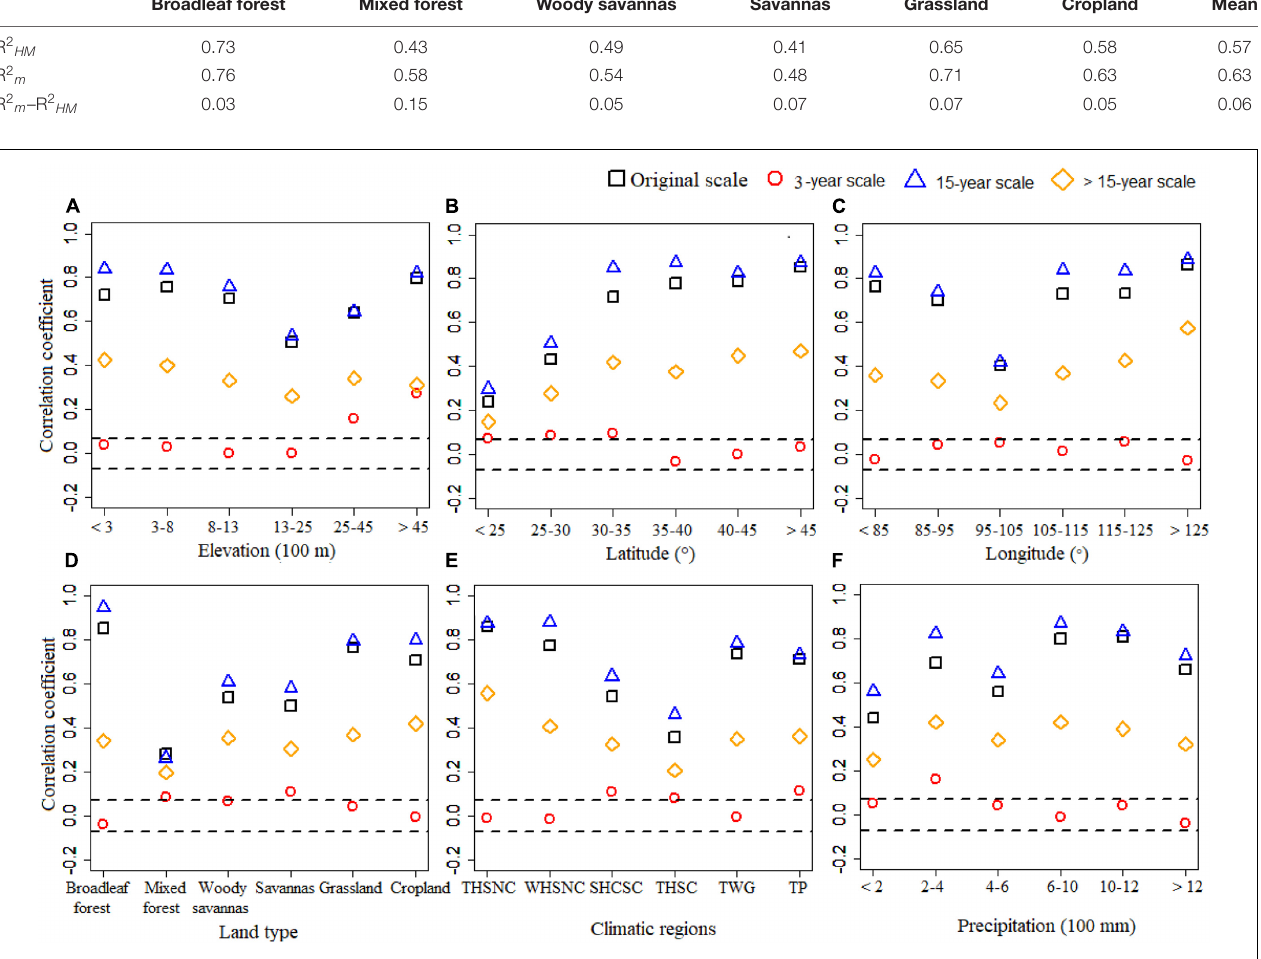
different land types), while the effect of DRT on NDVI was increased gradually with increased latitude. DRT had the lowest effect on NDVI at the half-month, 15-year, and > 15-year scales